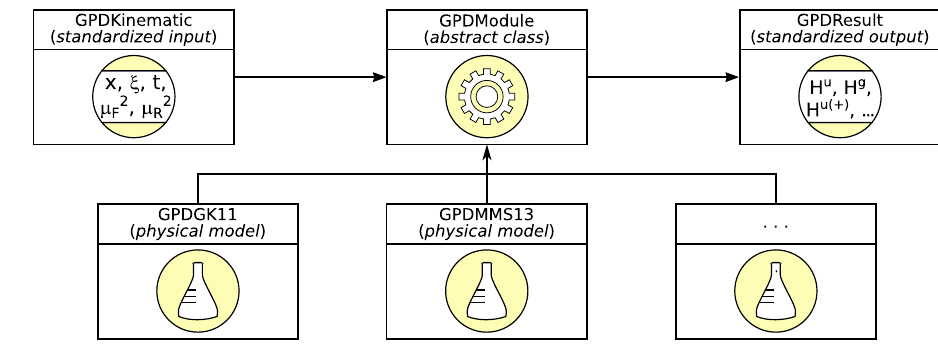
Fig. 5 Modularity through class inheritance and standardized inputs and